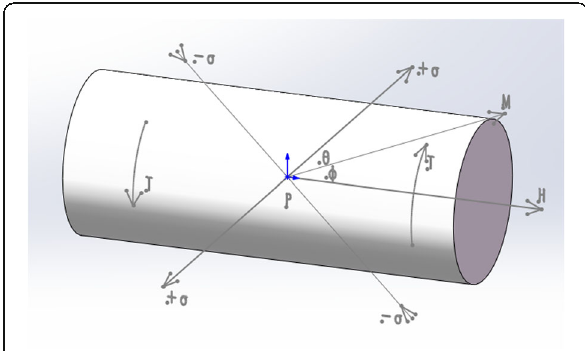
Fig. 1 The distribution of magnetization at a point on the outer surface of the